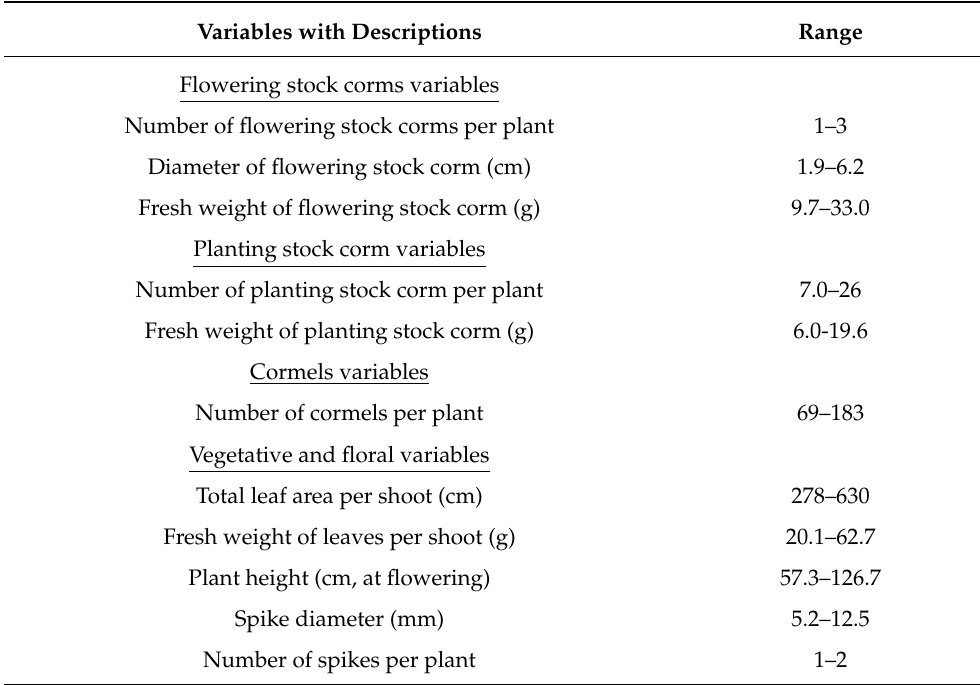
Table 1. Variables with detailed descriptions and the observed ranges as detected in our study (minimum and maximum